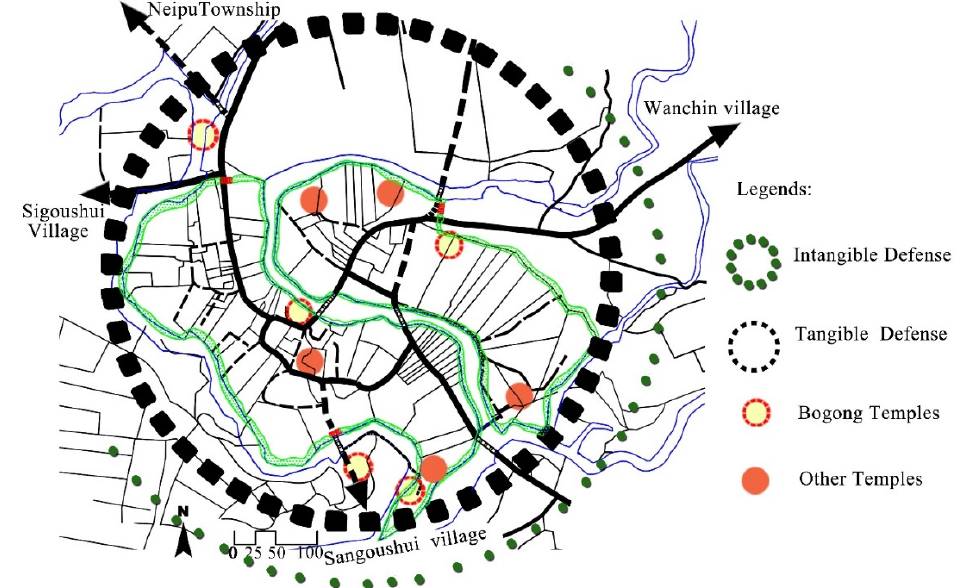
Figure 2. Defence Hierarchy of Wugoushui Settlement.